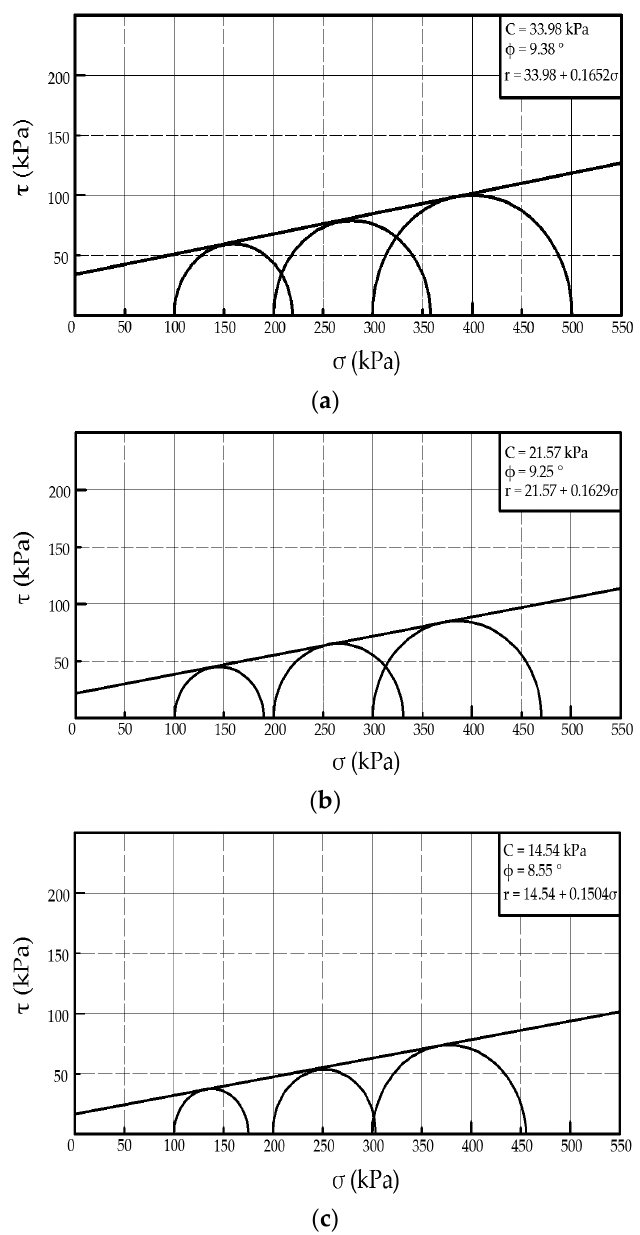
Figure 6. Shear strength envelope of UU test. ( a ) PMMRS, ( b ) SMMRS and ( c ) Pure CLS.